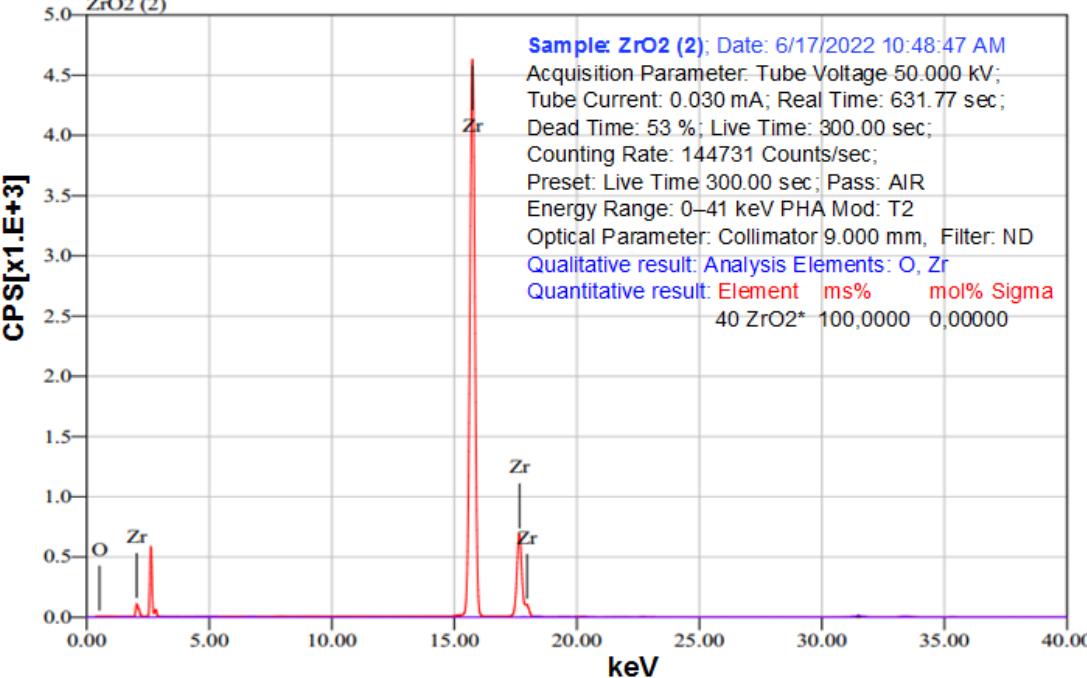
Figure 9. The XRF analysis for purified zirconia.